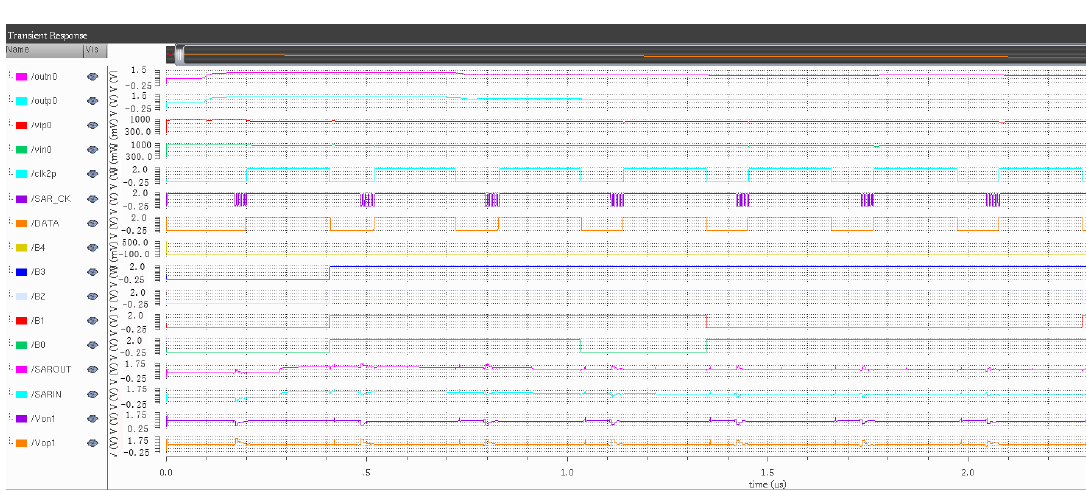
Figure 12. Function simulation diagram of the modulator.